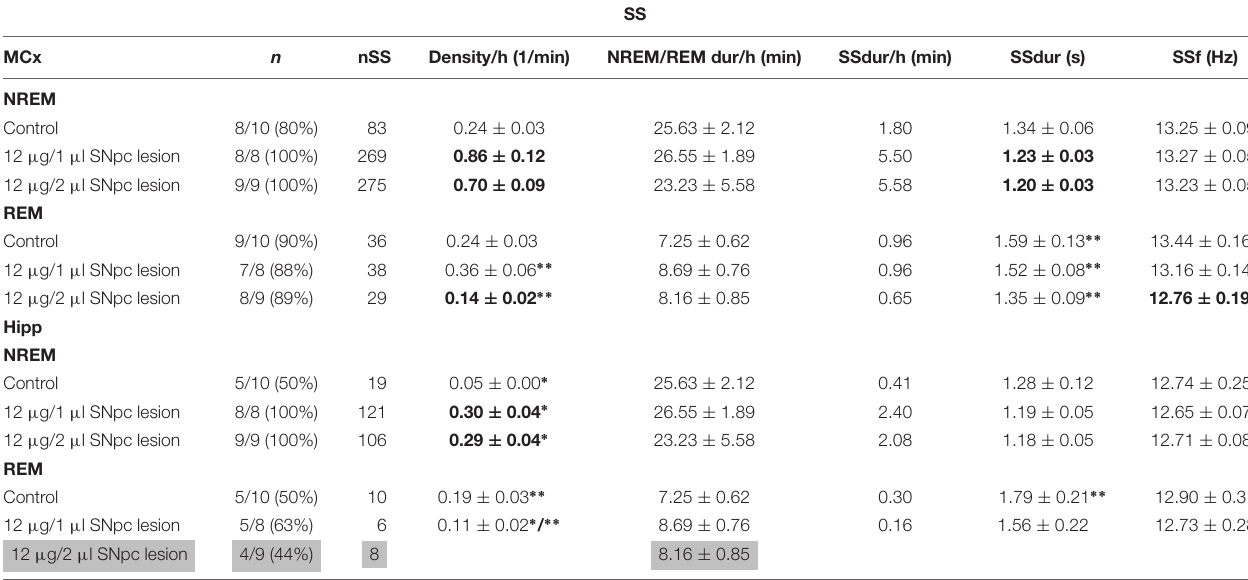
TABLE 2 | Sleep spindles (SS) dynamics during NREM and REM sleep.